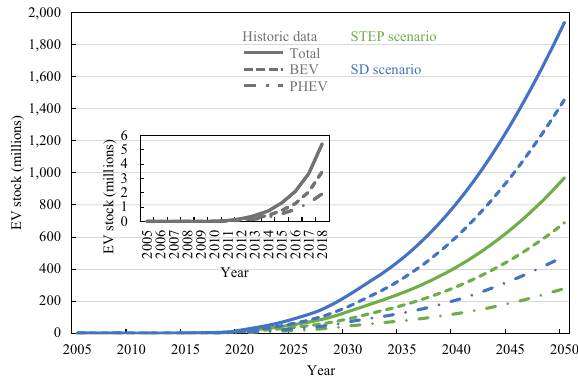
Fig. 1 Global EV stock development projected until 2050. BEV battery electric vehicle, PHEV plug-in hybrid electric vehicle, STEP scenario the Stated Policies scenario, SD scenario Sustainable Development